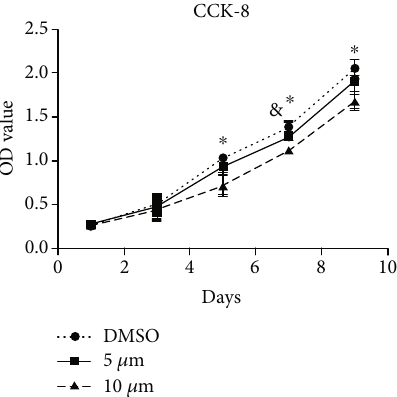
Figure 2: LY2109761 inhibits keloid-derived fi broblast proliferation. Cell proliferation was assessed using the CCK-8 assay in keloid-derived fi broblasts treated with increasing concentrations of LY2109761 on days 3, 5, 7, and 9. Data are presented as the mean ± SEM from three independent experiments. ∗ P < 0 : 05 between LY2109761 groups and DMSO control; ∗∗ P < 0 : 05 between LY2109761 5 μ M and 10 μ M treatment